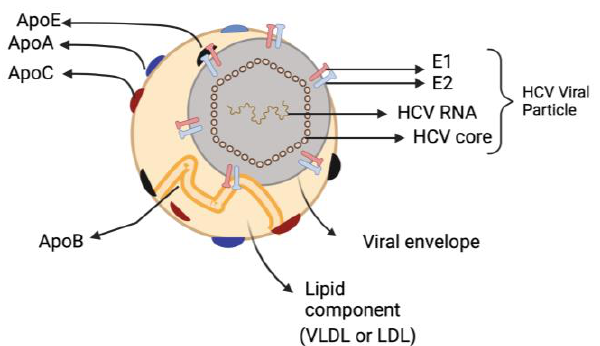
Figure 2. Hepatitis C virus Lipoviroparticles (LVP). The highly infectious HCV particle corresponds to a hybrid particle composed of VLDL or LDL components and viral components named LVP. VLDL: very-low density lipoproteins; LDL: low-density